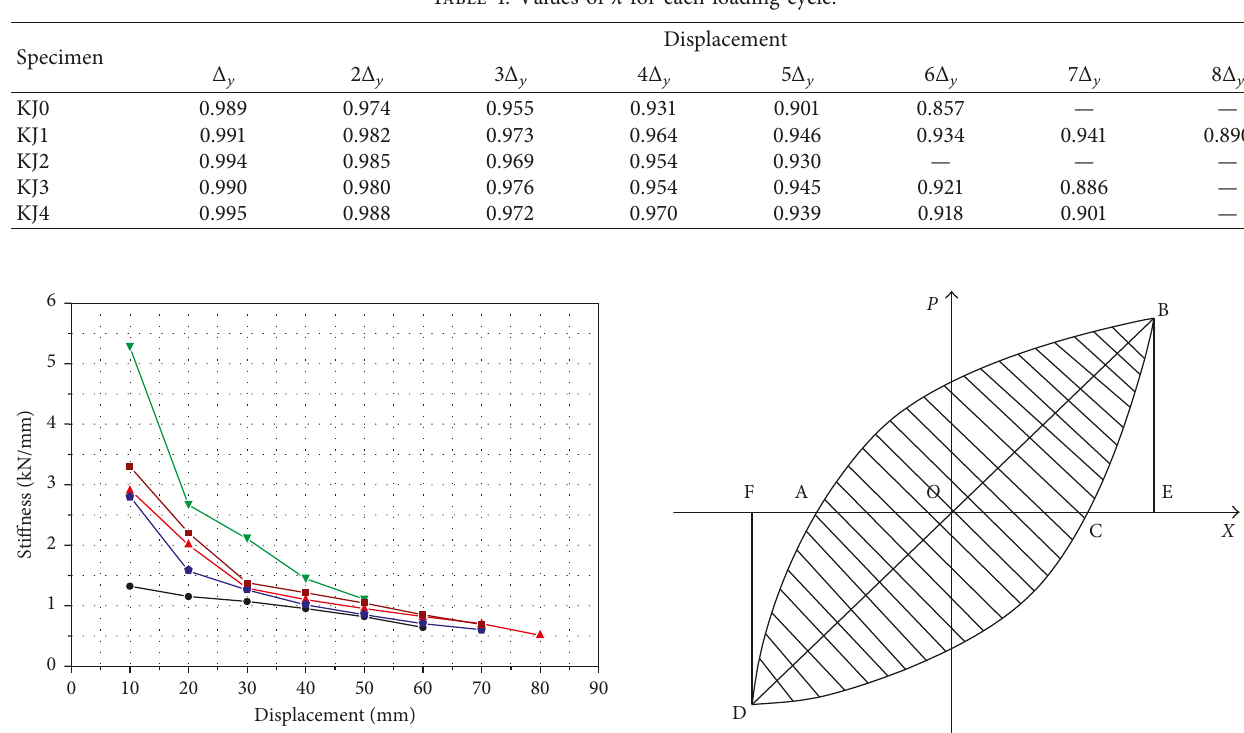
Figure 10: Calculating diagram of h